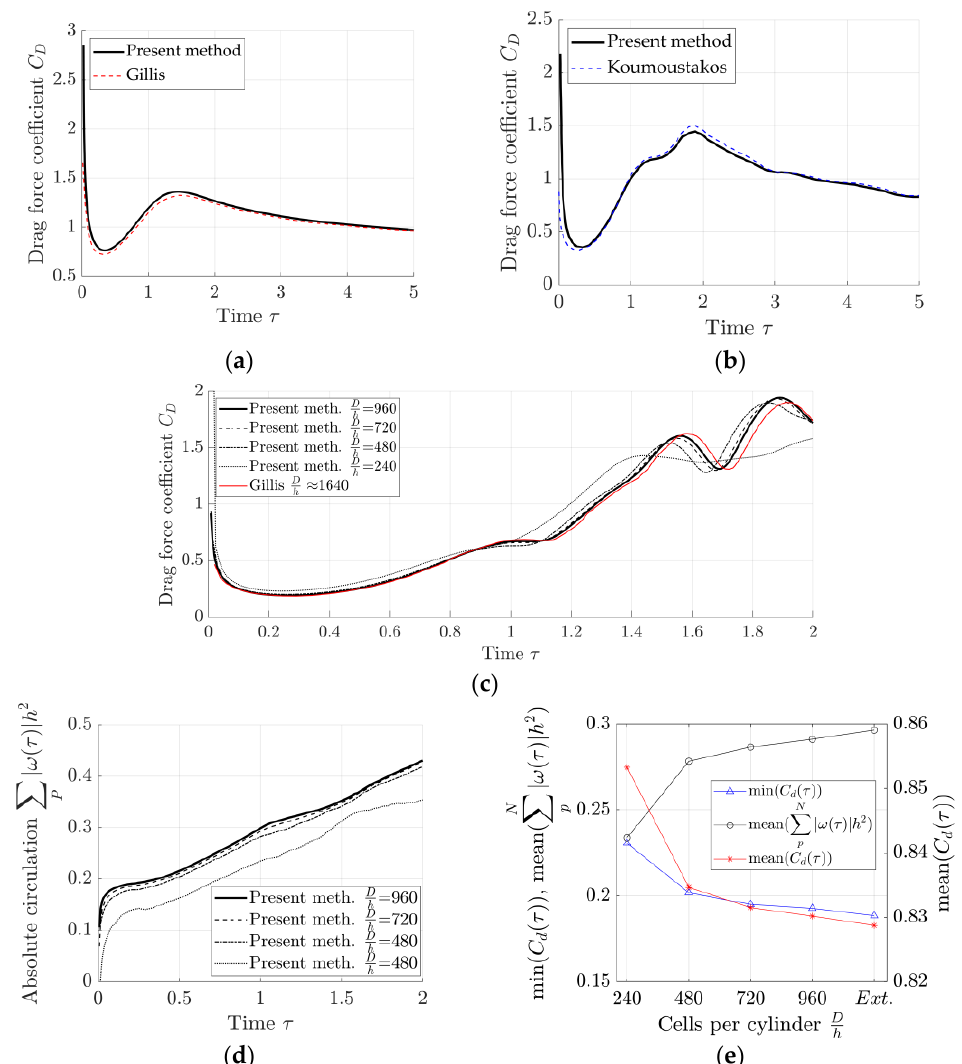
Figure 5. Drag coefficient change in time for: ( a ) Re = 550 [61]; ( b ) Re = 3000 [66]; ( c ) Re = 9500 [61]; ( d ) absolute circulation convergence; ( e ) statistical functions convergence.